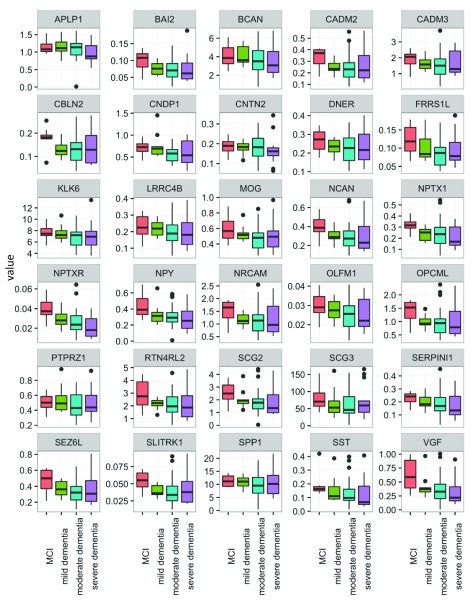
Distribution of candidate protein biomarkers in cerebrospinal fluid samples of set 1 (see text for definitions).Candidate proteins were measured with SRM assay and compared between mild cognitive impairment (MCI) (n=8), mild (n=11), moderate (n=24) and severe AD (n=15). Full gene names can be found in the website of the human gene nomenclature committee (
https://www.genenames.org/).